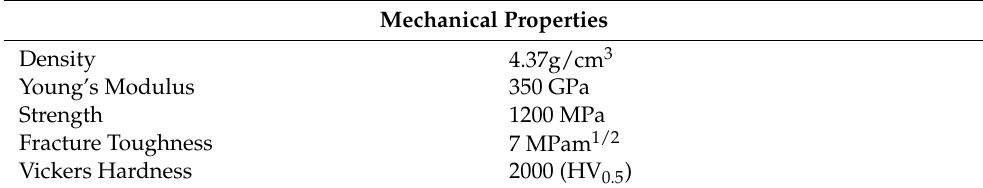
2 O 3 -Cr 2 O 3 -ZrO 2 -CeO 2